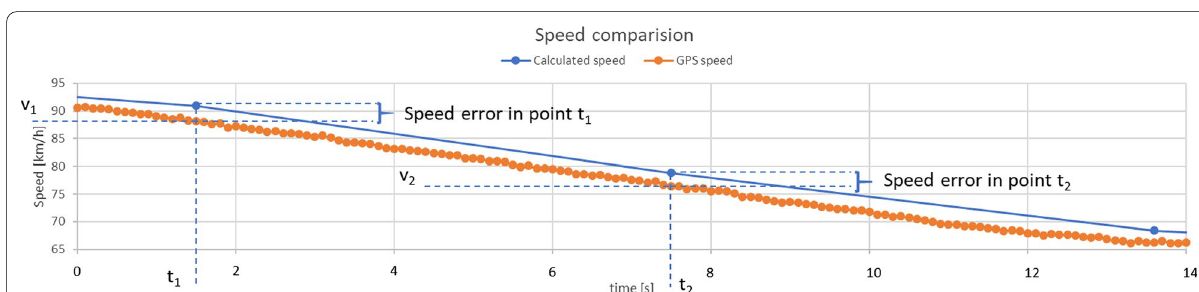
Fig. 9 Speed data from GPS versus speed calculation from suggested method; v 1 time point t 2